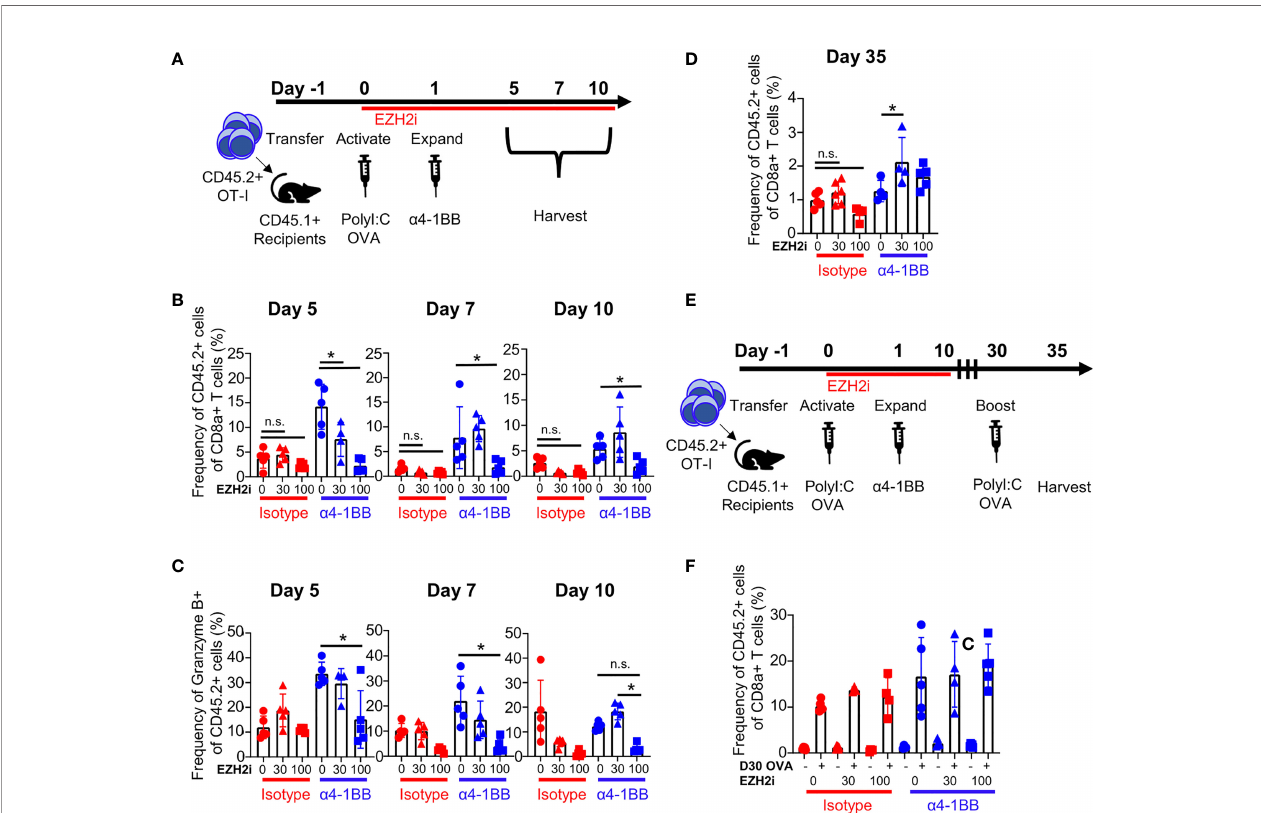
FIGURE 2 | EZH2i reduce the magnitude of the antigen-speci fi c effector response. Recipient mice (CD45.1 + ) received congenically mismatched donor (CD45.2 + ) OT-I + cells before being activated with OVA and PolyI:C, dosed with EZH2i and a 4-1BB (A) . On days 5, 7, and 10, the frequency of donor OT-I + cells (B) and donor cells producing Granzyme B (C) was determined in isotype-treated (upper panel) and a 4-1BB-treated (lower panel). On day 35 post activation, frequency of donor OT-I + cells was detected in recipient animals (D) . On day 30, one cohort of mice was given a second injection of OVA and PolyI:C and both cohorts (untreated memory and OVA/PolyI:C-treated memory) were taken down 5 days later (E) and relative expansion compared to an untreated cohort was determined (F) . Mice treated with isotype are marked in red; mice treated with a 4-1BB are marked in blue. Vehicle treated control mice are marked with circles; triangles indicate 30 mpk EZH2i treatment while squares indicated 100 mpk EZH2i treatment. Asterisks (*) indicate p<0.05 as determined by 2way ANOVA and post hoc comparison of group means. n.s. indicates non-signi fi cant result. n ≥ 4 mice per group for immunization studies (A – C) . n ≥ 3 mice per group for memory studies (D – F)